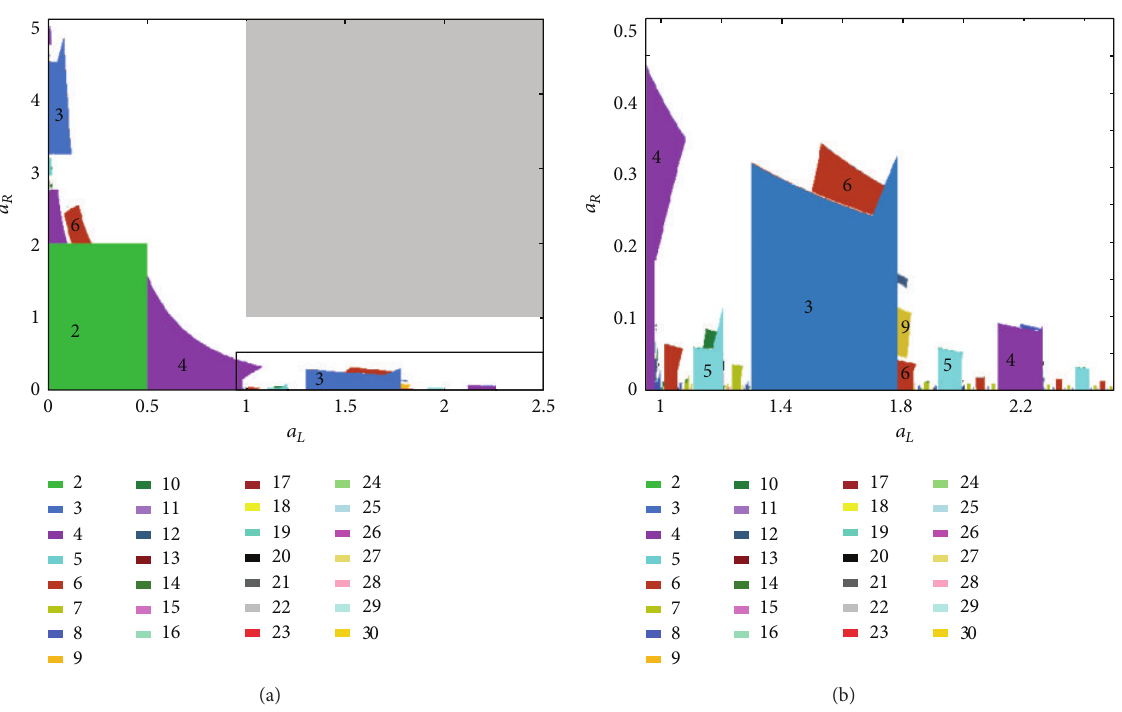
Figure 3: 2D bifurcation diagram of the map 𝑓 in the (𝑎 𝐿 , 𝑎 𝑅 ) -parameter plane in (a), at 𝑑 𝐿 = 0.4 , 𝑑 𝑅 = 0.8 , and an enlargement of the indicated window in (b). The color bar indicates the correspondence of a color and the period of the related